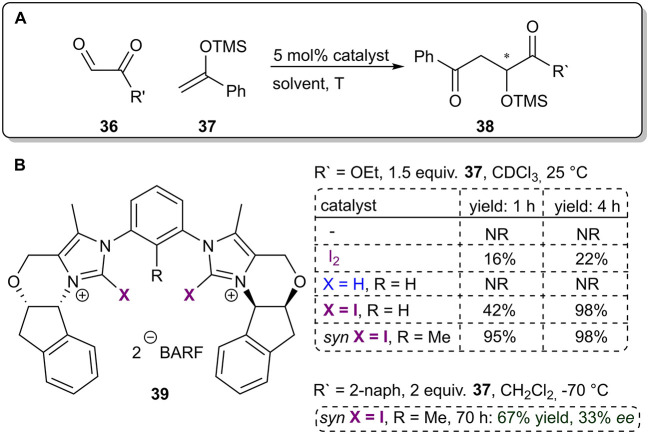
(A) Enantioselective XB-catalyzed Mukayama aldol reaction, yields refer to approximate values from Figure 6 in the publication (Sutar et al., 2020); (B) influence of the structure of the catalyst and reaction conditions on the reaction outcome.